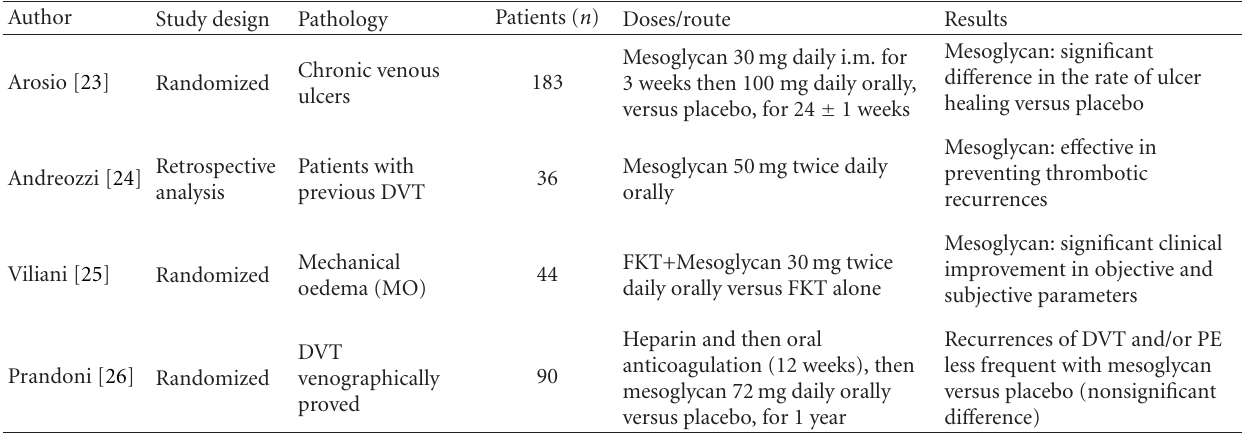
Table 3: Mesoglycan and venous